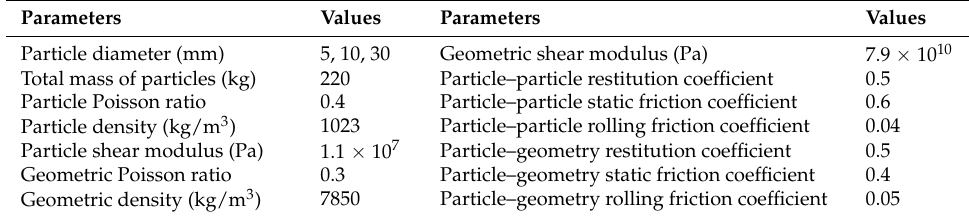
Table 1. DEM parameters used in simulations.